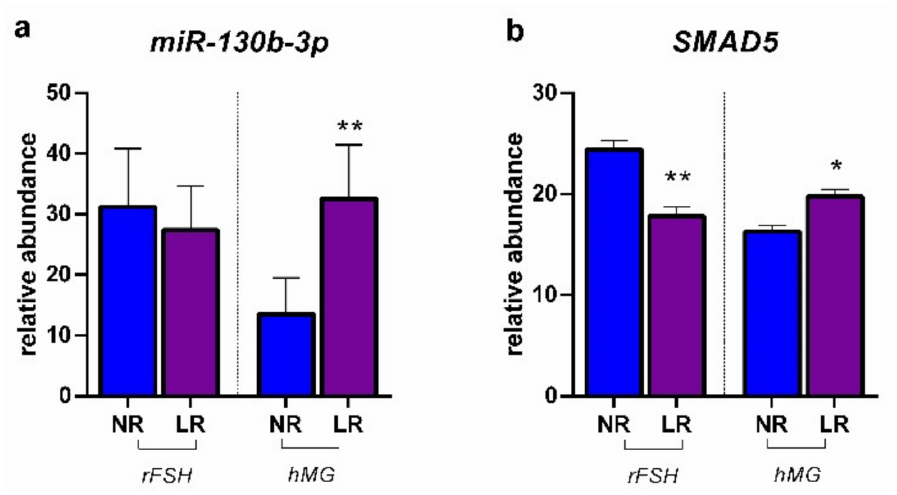
Figure 4. Expression profiles: ( a ) miR-130b-3p; ( b ) SMAD5 : smad family member 5. Results are reported as mean ± standard deviation. Statistical significance was set at p < 0.05 and calculated by Student’s t -test. Asterisks above columns indicate statistical differences between NR and LR groups. * = p < 0.05; ** = p < 0.01.